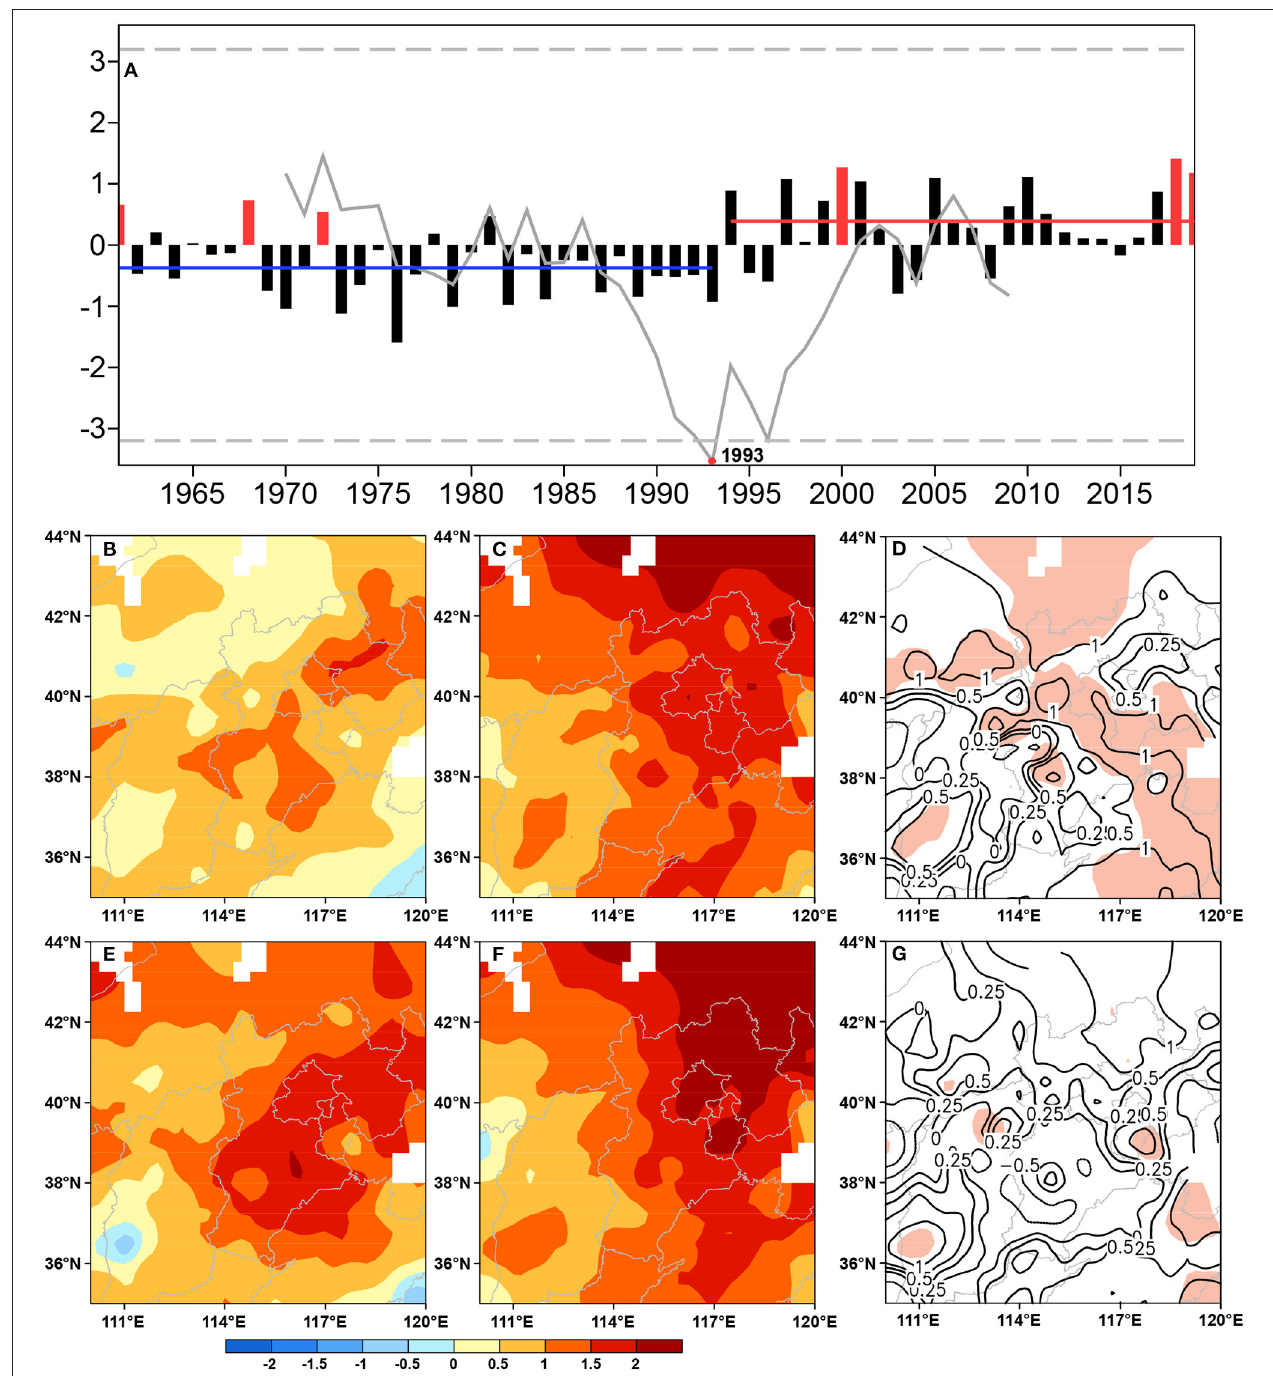
FIGURE 1 | The 1961–2019 time series of (A) the early summer mean temperature anomalies averaged over North China (black bars, units: ◦ C; blue line is the mean temperature anomalies averaged in the cold period; red line, warm period; red bars represent the selected extremely warm years) and running t -test (gray dashed lines indicate the 95% significance level; red dot represents the abrupt change year 1993). The mean (the second line) and maximum (the last line) temperature anomalies distribution (units: ◦ C) of EWES in North China during (B,E) the cold period, (C,F) the warm period, and (D,G) the difference between the warm period minus the cold period (contour: mean temperature anomalies; shading areas indicate the 95% significance level).